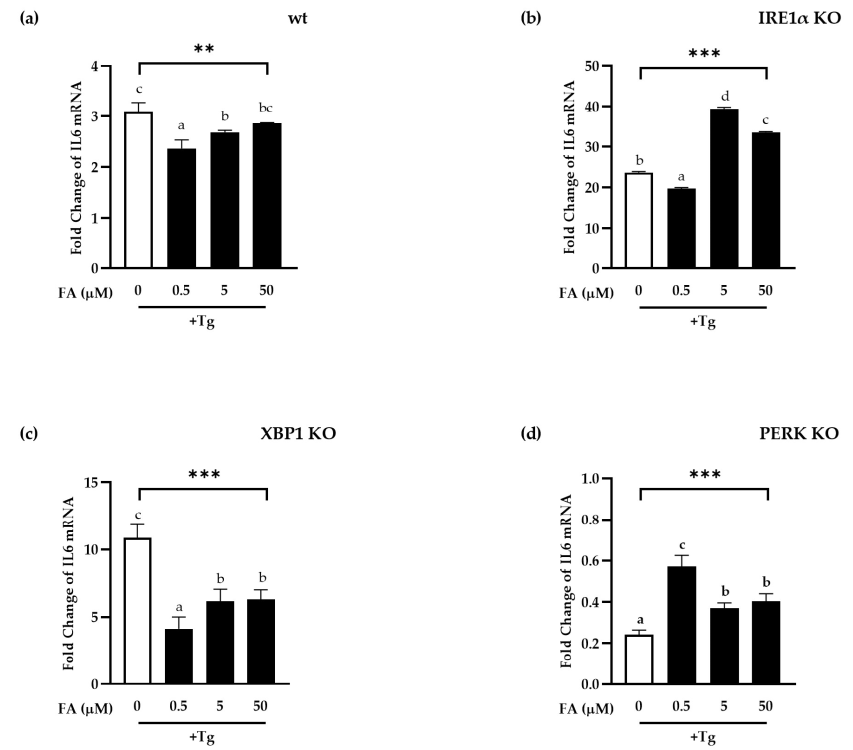
Figure 4. Effect of ferulic acid on the anti-inflammatory response in ER stress-induced MEF cells. FA were pretreated for 24 h before being treated for 4 h with Thapsigargin (Tg) on wild type (wt) ( a ), IRE1 α Knock-Out (KO) ( b ), XBP1 KO ( c ), PERK KO ( d ) MEF cells. Total RNA were extracted and cDNA were prepared for real-time qPCR. Mouse IL6 and XBP1s level were normalized by mouse β -actin. Data are the means ± SEM of the representative experiment. Duncan’s multiple range